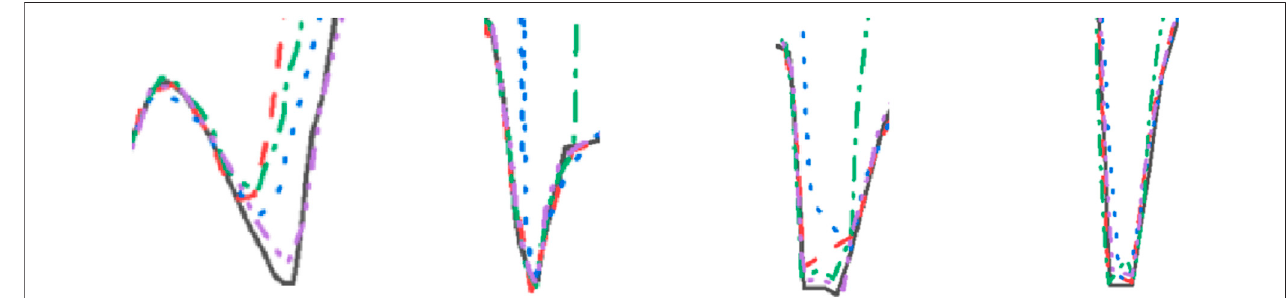
FIGURE 16 | Partial enlargement of the